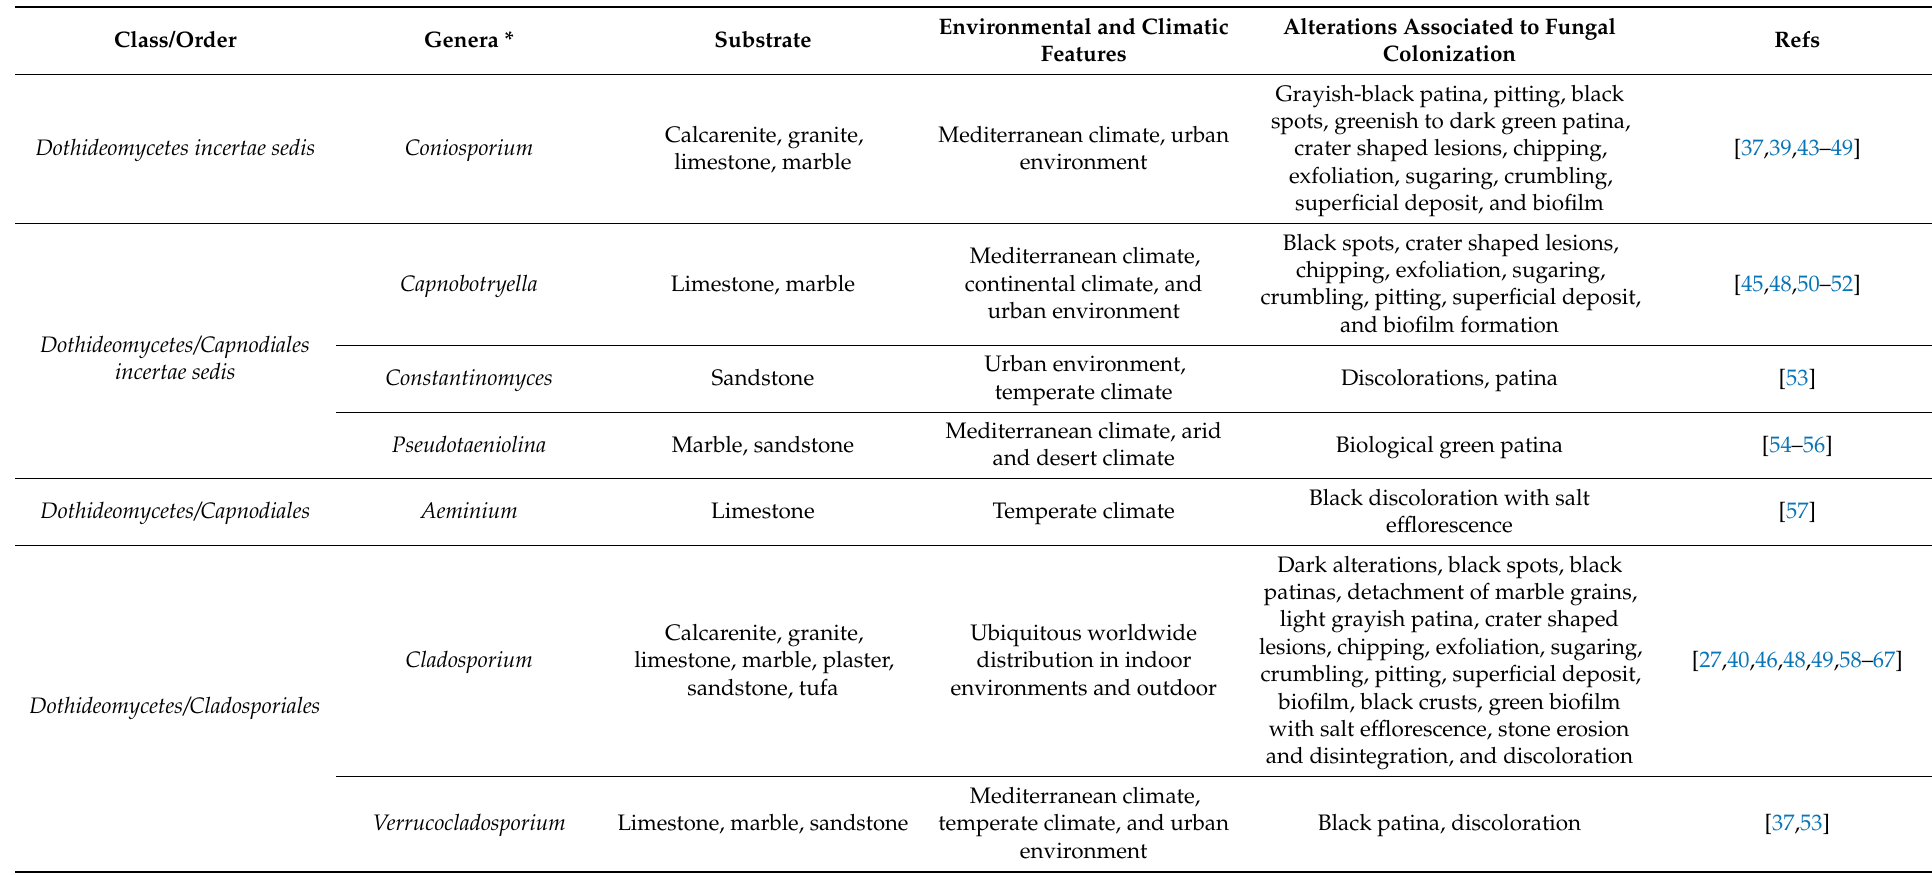
Table 1. Genera of black fungi isolated from stone monuments in the period from 1997–2022 in association with visible